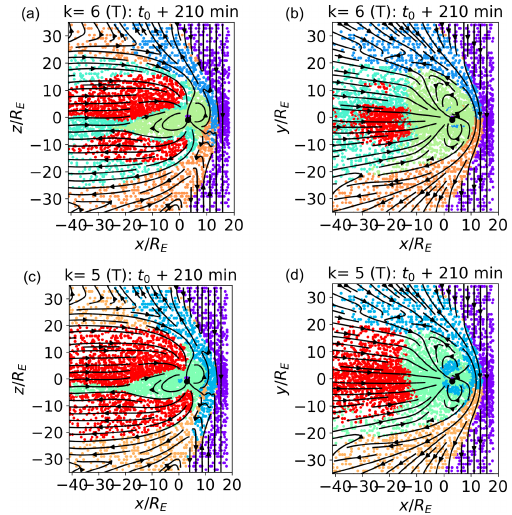
Figure B1. y/R E = 0 (a, c) and z/R E = 0 (b, d) cuts with k = 6 (a, b) and k = 5 (c, d) . The training data set is depicted.